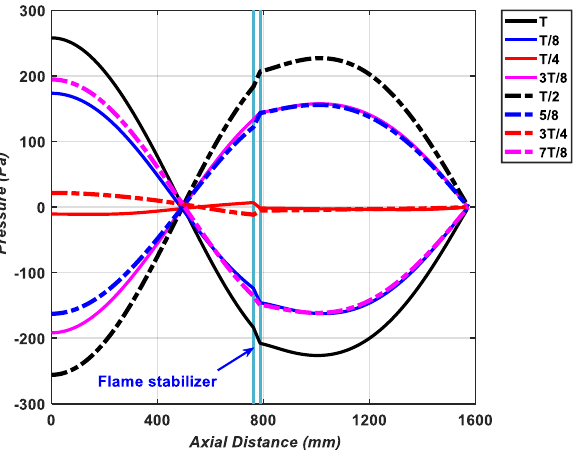
Figure 12. Pressure distribution along the centerline at different times of a limit cycle [Pa].